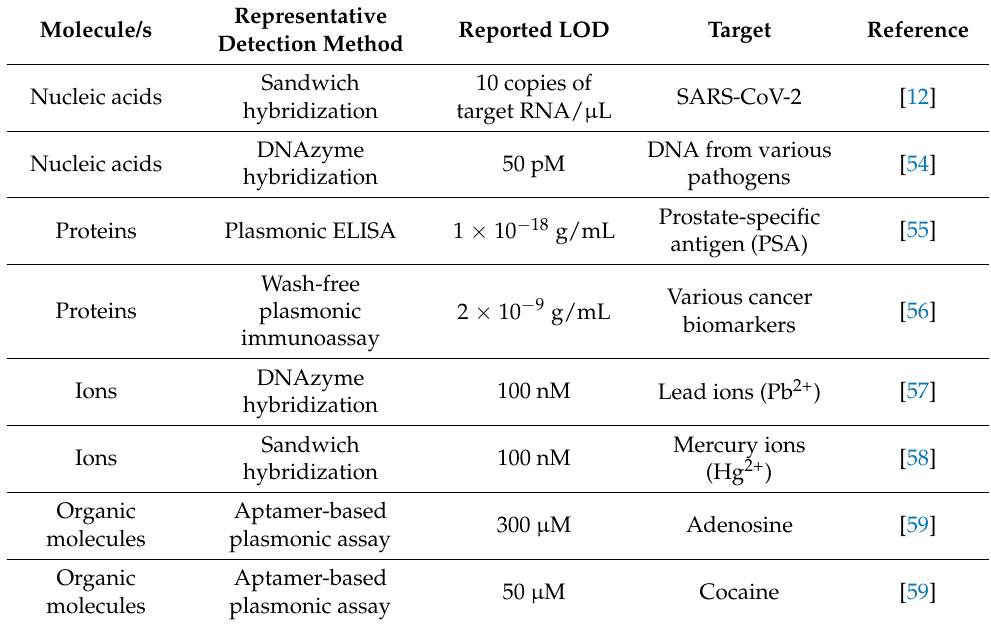
Table 2. Summary of selected representative methods of detection detailed in the following sections. The limit of detection (LOD) is defined as the lowest assayed concentration of analyte that yields a signal higher than three times the standard deviation of the negative controls expressed in the units used in the relevant